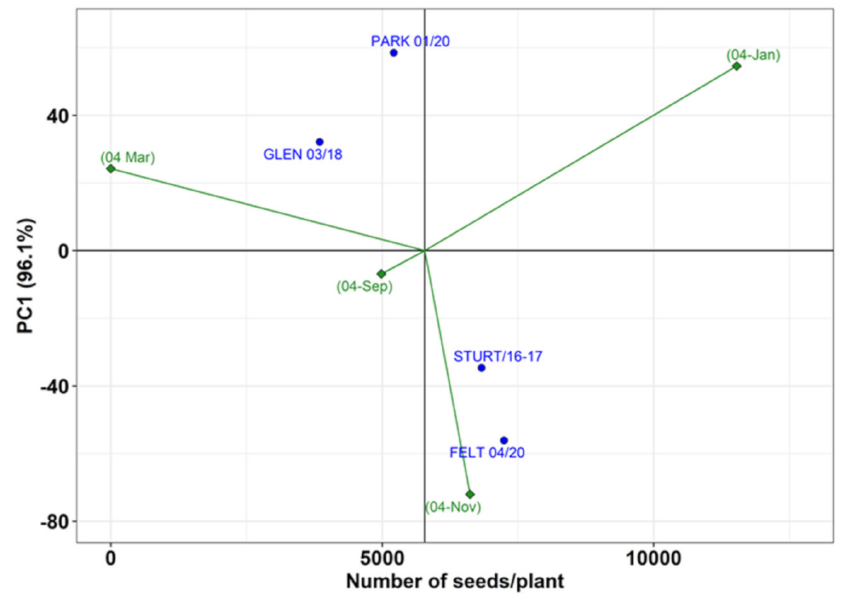
Figure 7. Additive main effects and multiplicative interaction (AMMI) biplot for seed production of four populations at four different sowing